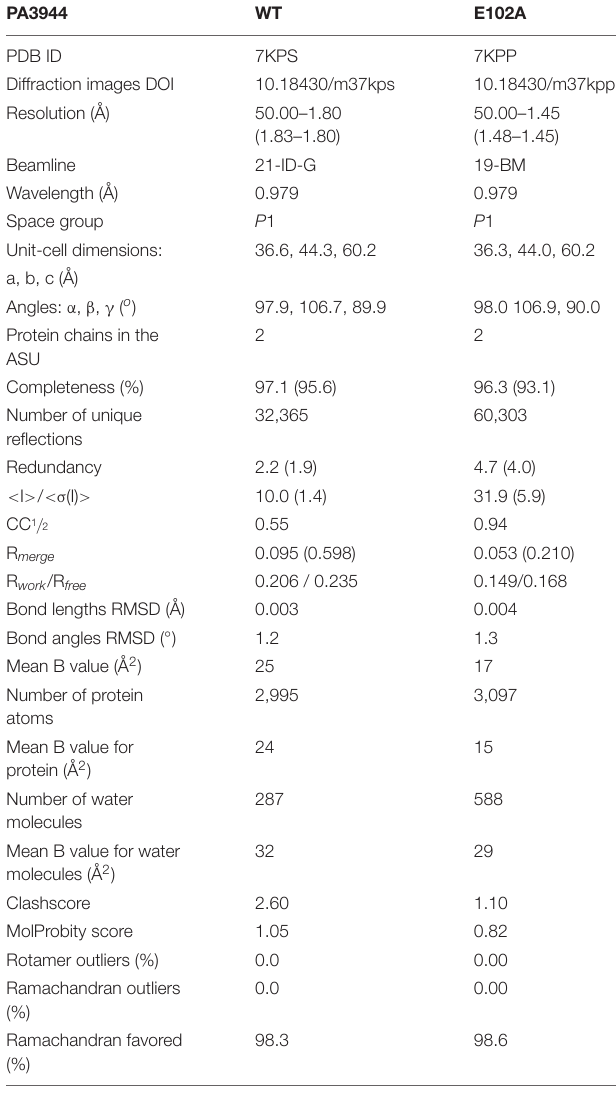
TABLE 2 | Data collection, structure refinement, and structure quality